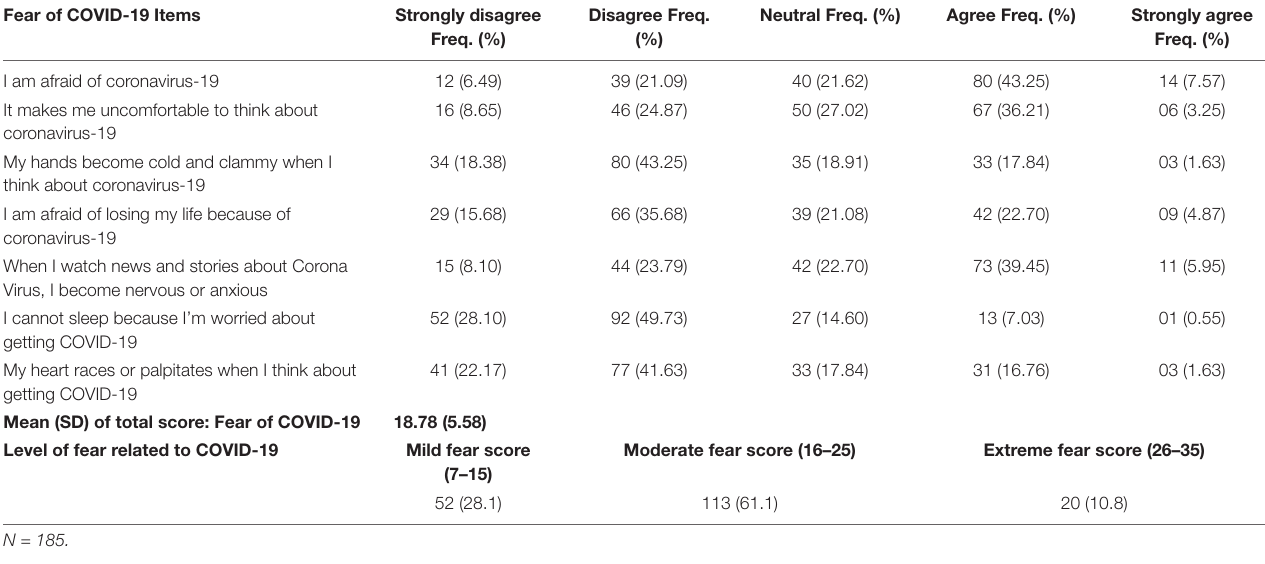
TABLE 2 | Participants’ fear related to COVID-19.